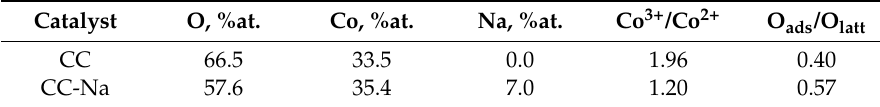
Table 2. Surface composition results from XPS.